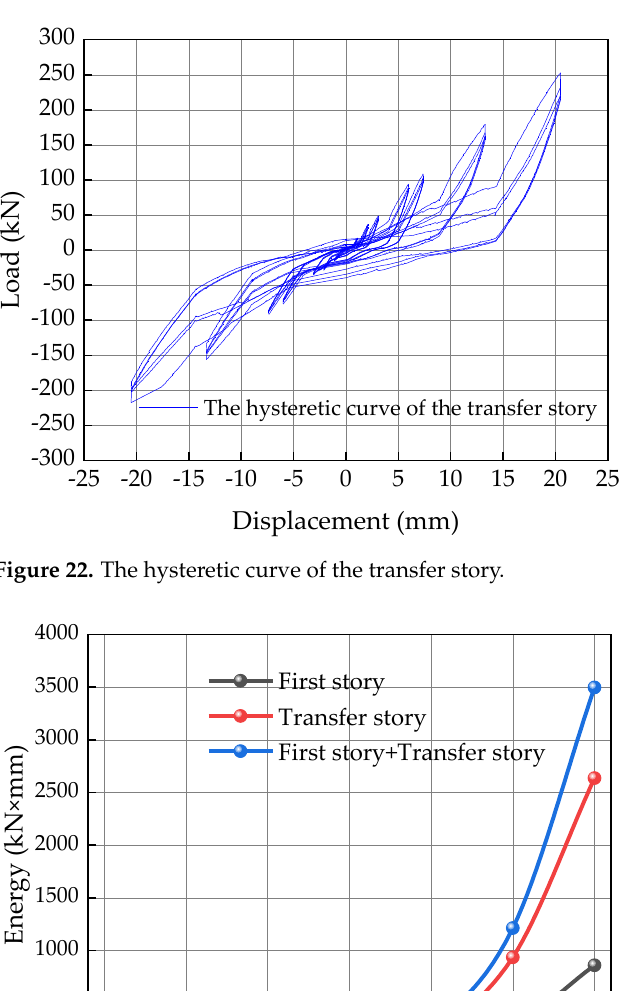
Figure 24. Area chart of energy consumption capacity. Table 5. Equivalent viscous damping coefficient. Loading Conditions